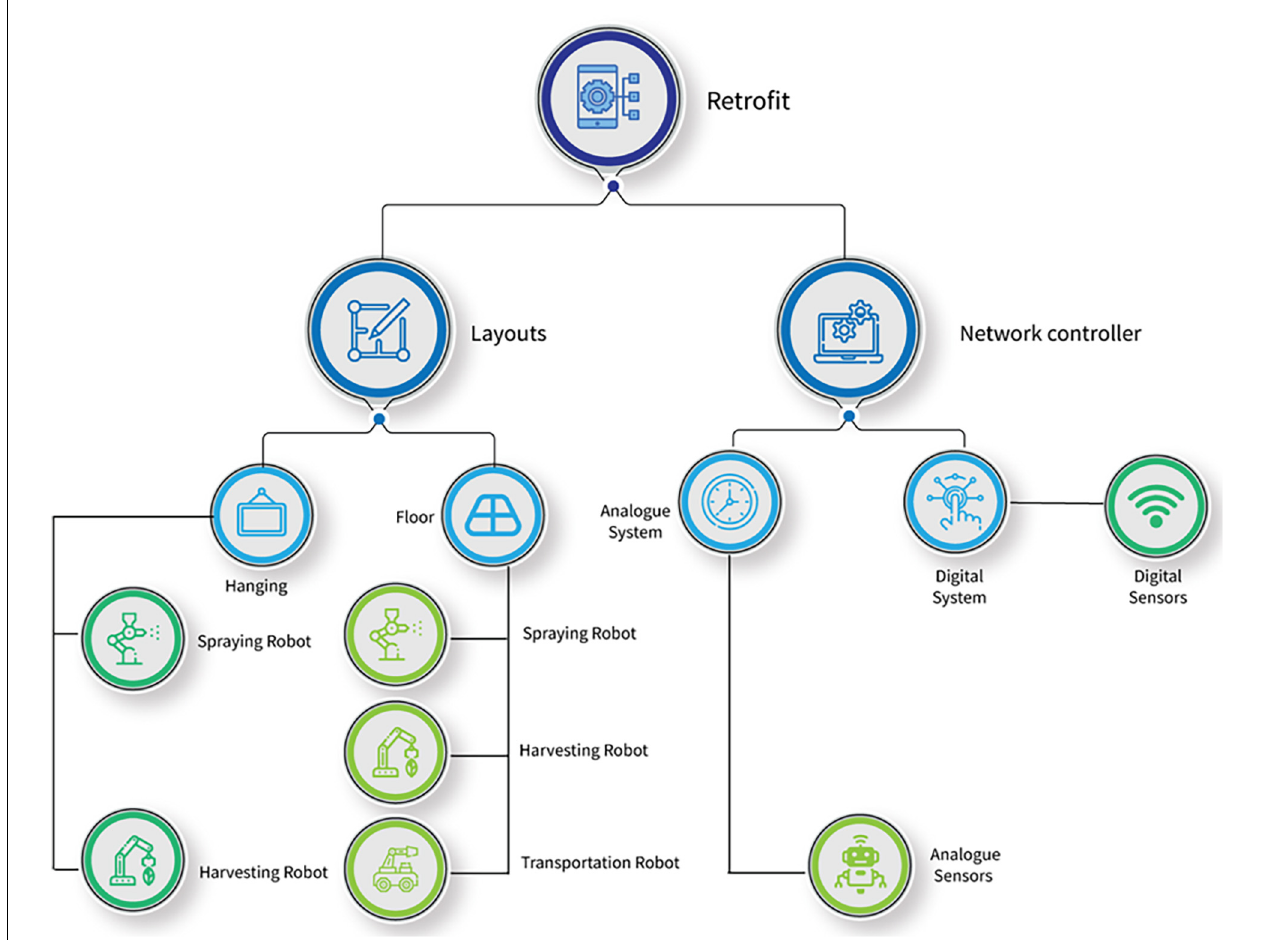
FIGURE 2 | Tree showing constraints for implementing